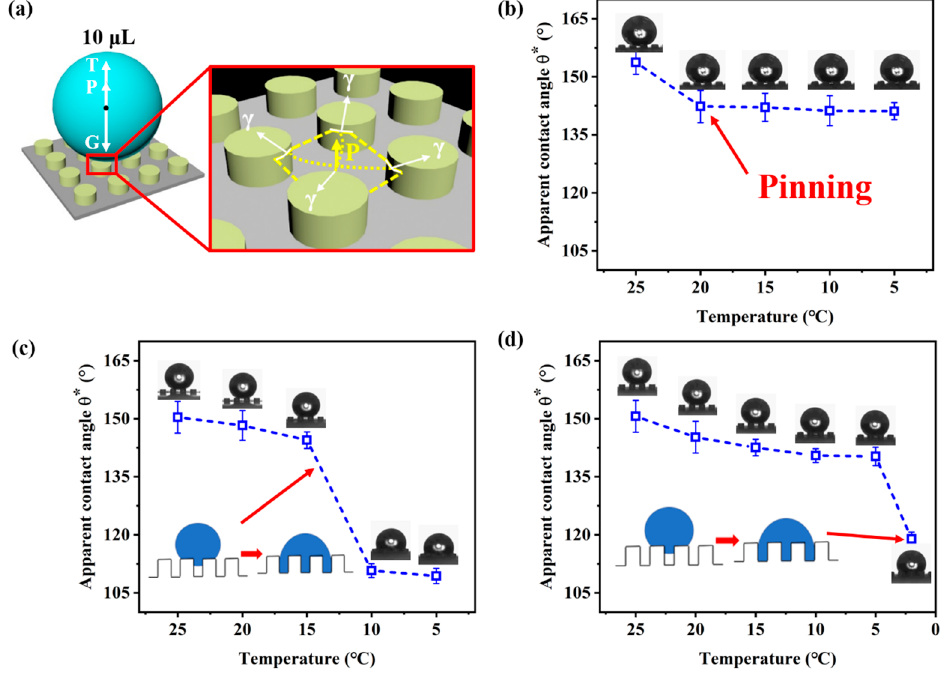
Figure 3. ( a ) Schematic diagram of wetting state at room temperature. ( b – d ) Changes in contact angle with temperature on the superhydrophobic surfaces with the pillar height from 200 to 250 μ m and 300 μ m.